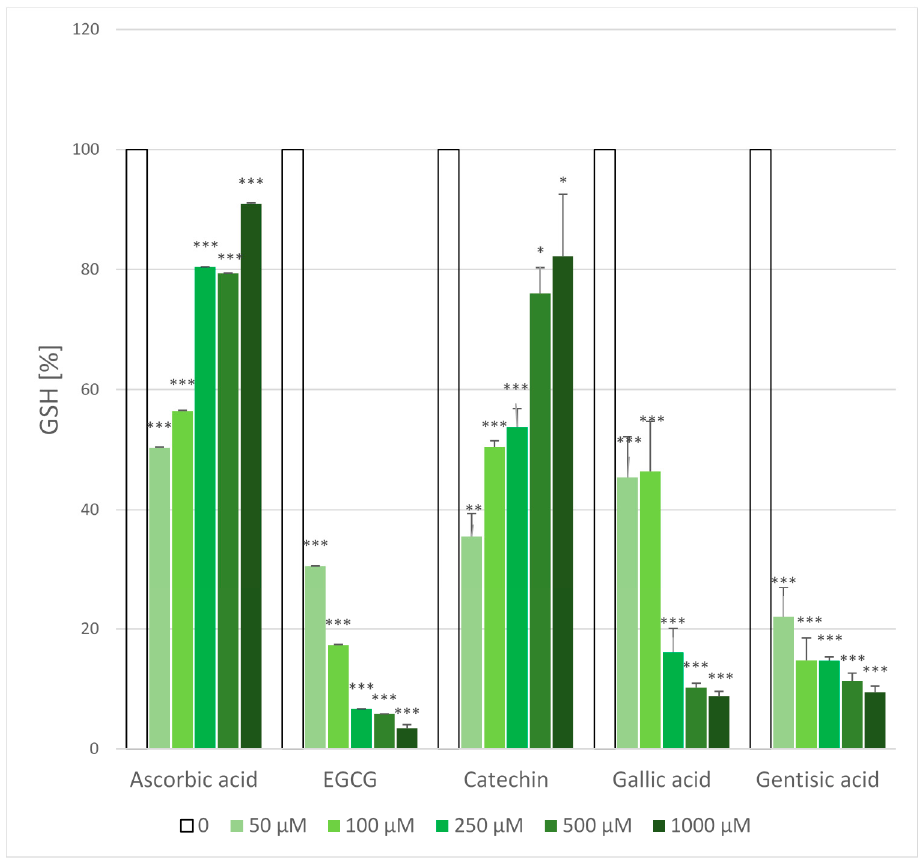
Figure 6. E ff ect of antioxidants on the AAPH-induced loss of erythrocyte glutathione (GSH). GSH level in AAPH-treated erythrocytes was assumed as 100%. * p < 0.05, ** p < 0.01, *** p < 0.001 with respect to control.